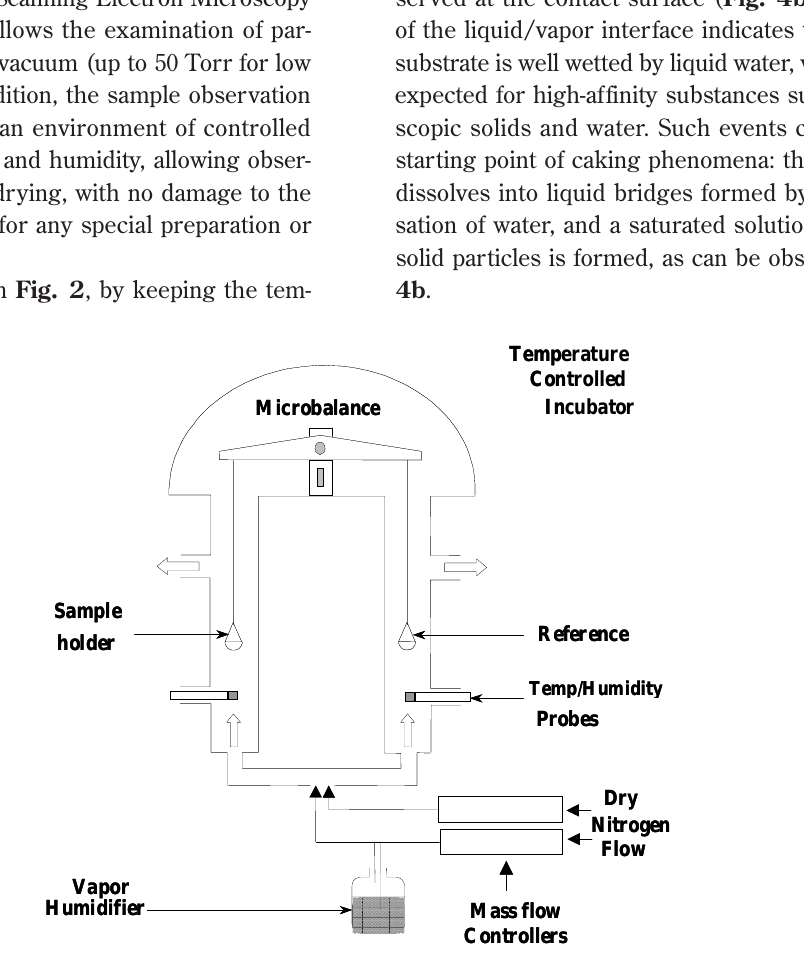
Fig. 3 Schematic representation of the Dynamic Vapor Sorption